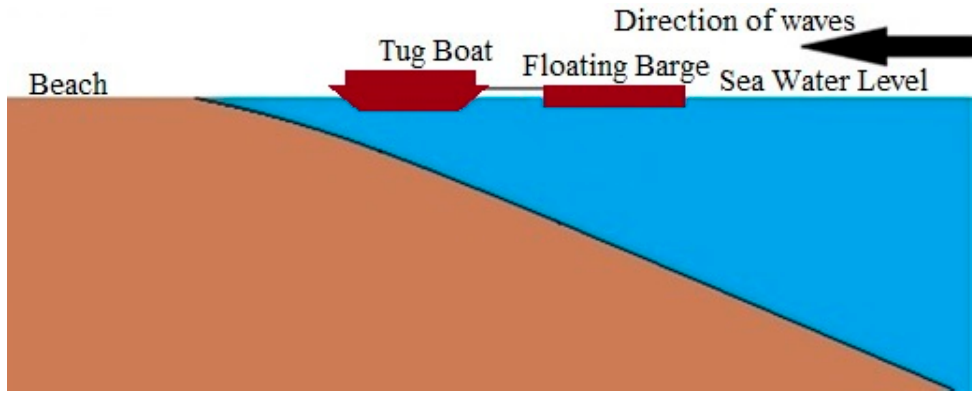
Figure 4. Towing of barge to the